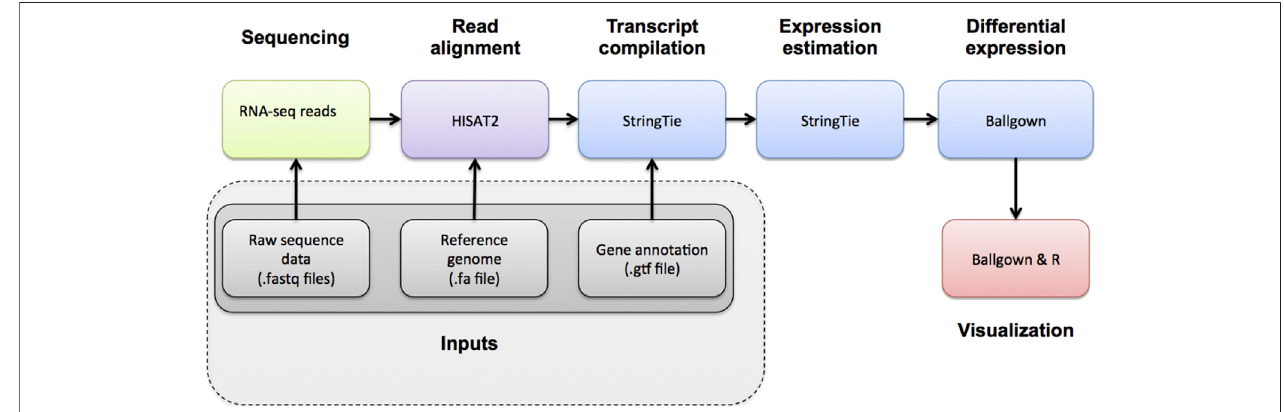
FIGURE 2 | The whole procedure of bioinformatic analysis of